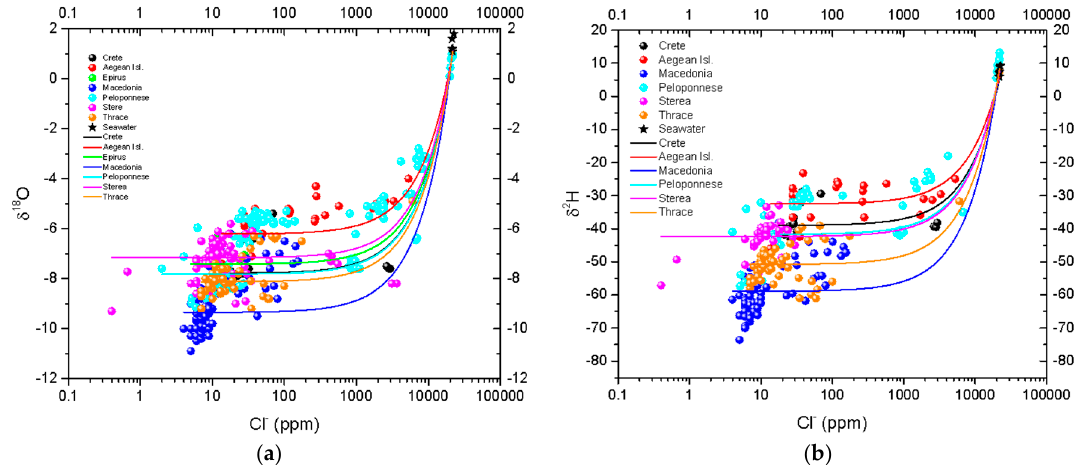
Figure 7. ( a , b ) Variation of Cl − versus δ 18 O and δ 2 H, respectively. Seawater-precipitation lines for each region are provided.